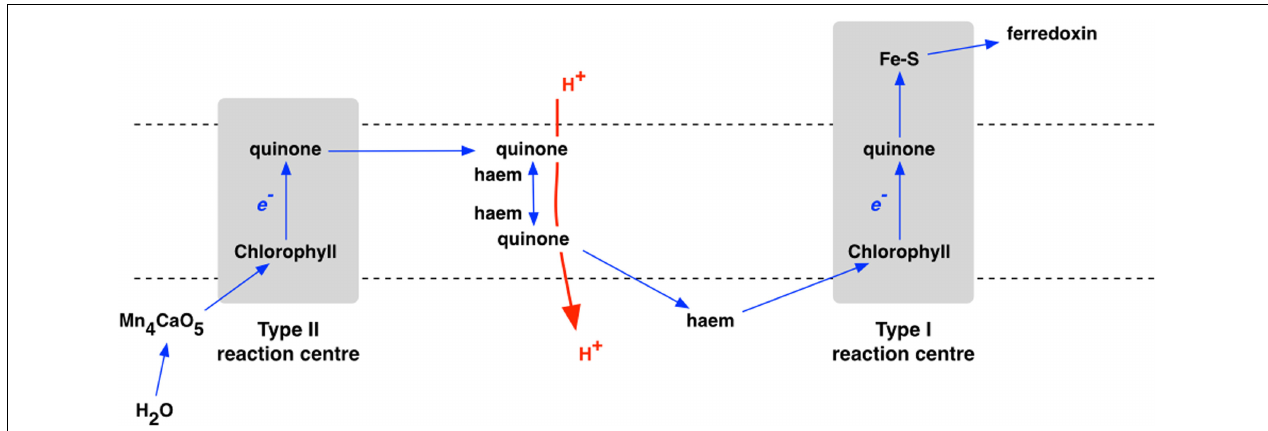
FIGURE 3 | The electron transport chain of oxygenic photosynthesis, where Types II and I reaction centers are linked, in series, as photosystem II (PS II) and photosystem I (PS I), respectively.